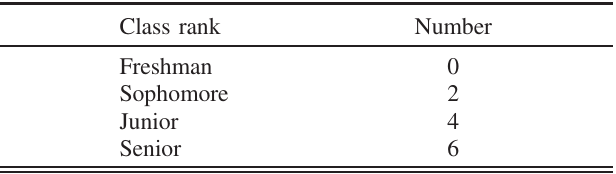
TABLE III. Class ranks of the learning assistants interviewed.